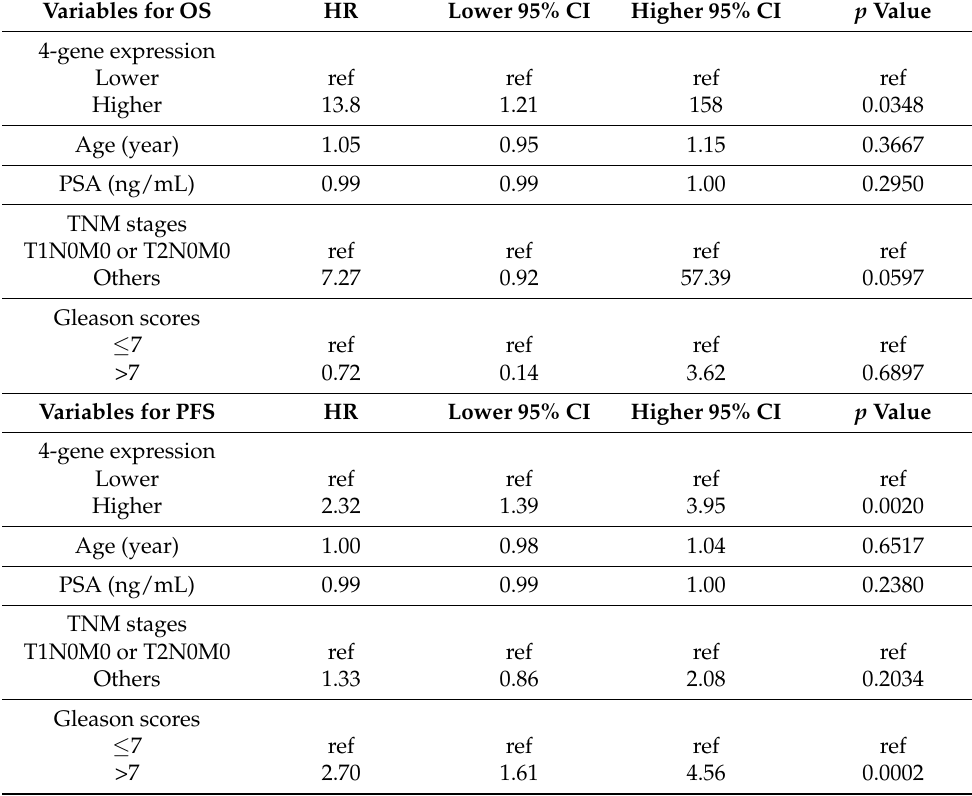
Table 2. Multivariate Cox regression analysis for OS and PFS.